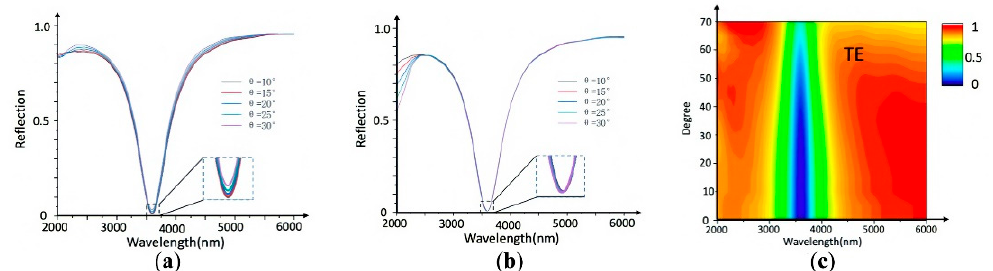
Figure 4. Spectral reflectance curves of the optical switch at different incident angles for the ( a ) TE polarization and ( b ) TM polarization. The incident angle steps in 5°, from 10° to 30°. ( c ) Reflectivity of the optical switch at different incident angles for TE polarized light.